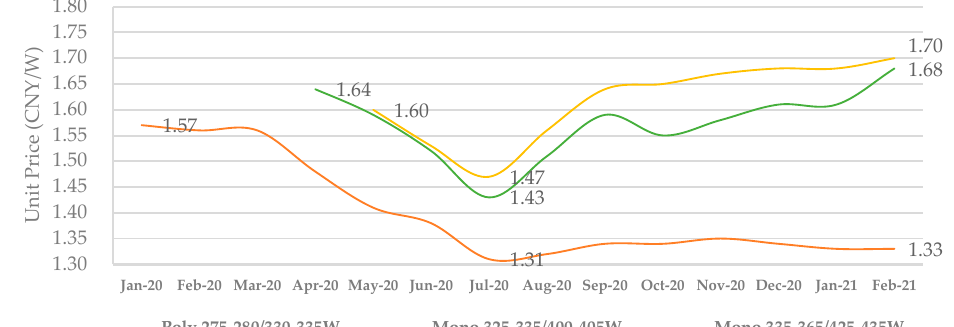
Figure 10. Price trend of solar PV panels from January 2020 to February 2021. Source: https://news.solarbe.com/202102/25/335122.html (accessed on 20 April 2020).